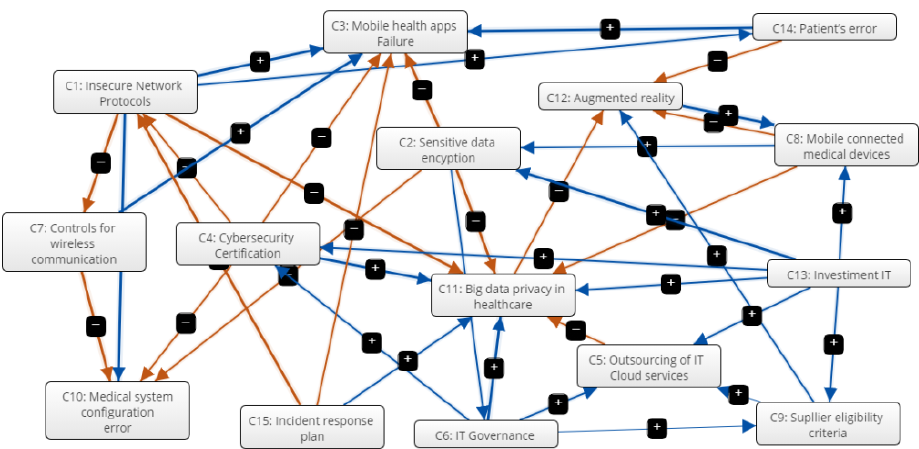
Figure 1. Model FCM cybersecurity in the telehealth university hospital.